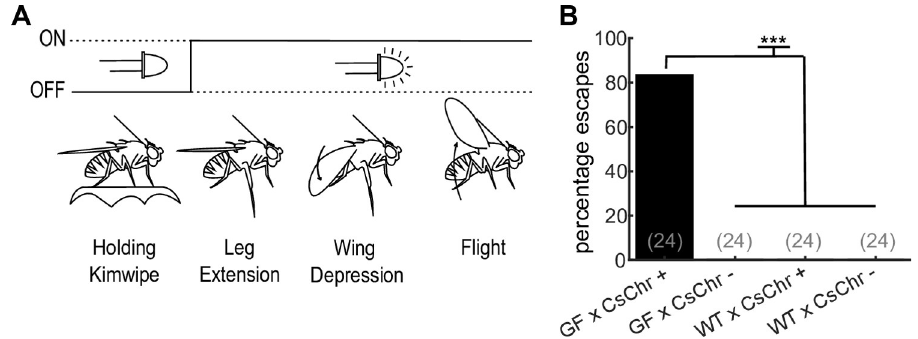
Fig 2. The optogenetics device replicates prior GF activation studies. ( A ) Annotated response of optogenetic GF activation shows the fly holding a small piece of a Kimwipe before light stimulation, followed by subsequent leg extension, wing depression, and flight initiation after light stimulus presentation. ( B ) Percentage of escapes across genotypes (n = flies as stated in figure, χ 2 test, P << .001, Bonferroni correction post hoc, ��� = p < .001). Abbreviations: retinal food (+), standard food (-), GF-split-GAL4 (GF), Canton S wild type (WT), UAS-CsChrimson (CsChr).